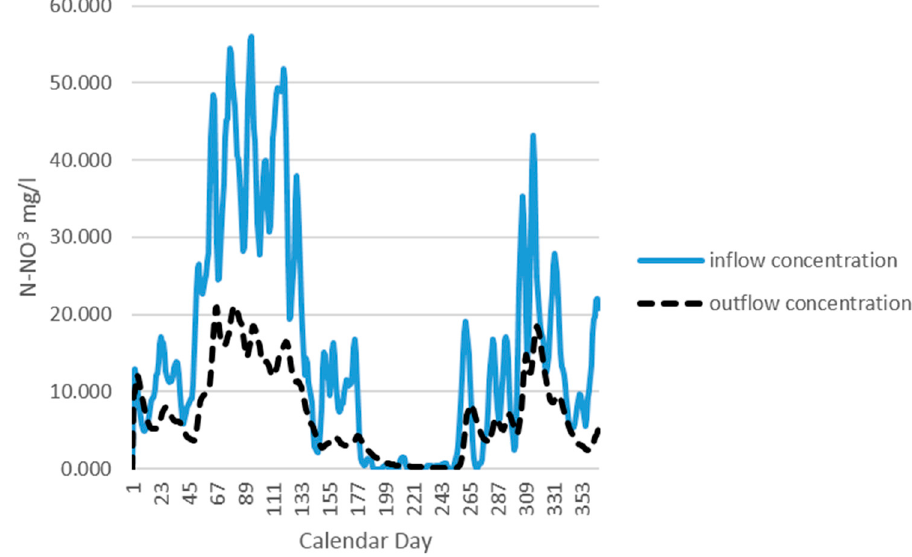
Figure 6. Modeled nitrate removal predictions. The inflowing concentration is shown in blue with the outflow as the black dashed line. Removal efficiency was predicted to be greatest during calendar days 180 to 250 (July and August) and least during calendar days 40–180 (months of February to May).